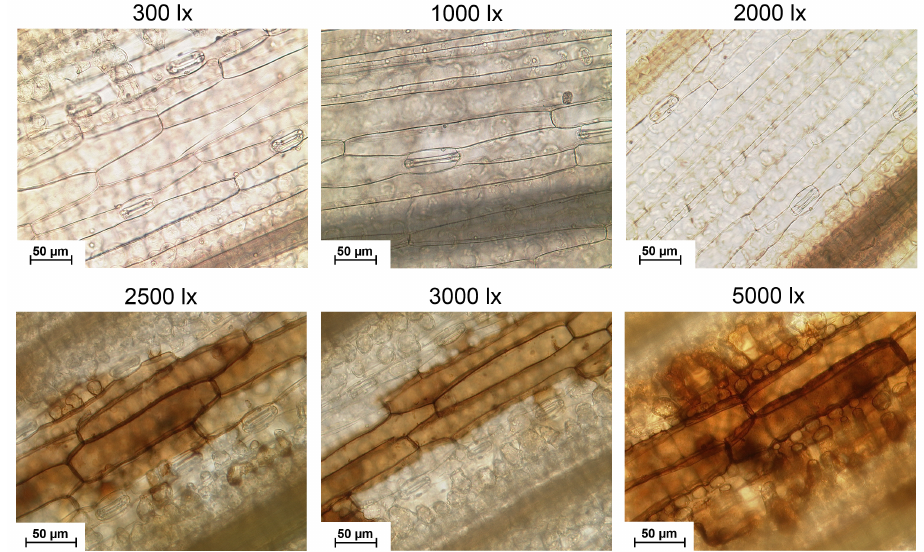
Figure 3. Microscopic observation of H 2 O 2 generation after staining due to tissue damage in barley leaves stained with DAB after hyperspectral imaging with UV-light source with different illuminances from 300–5000 lx.